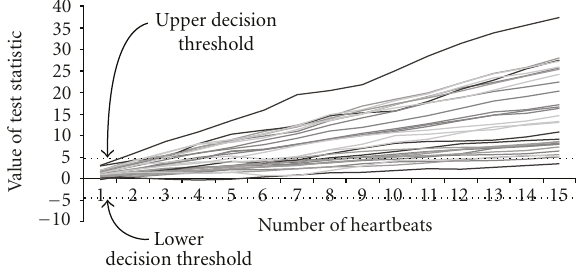
Figure 10: Sequential test statistics for all subjects when H 1 is true. The test data are from the subject closest to the declared individual, that is, the nearest